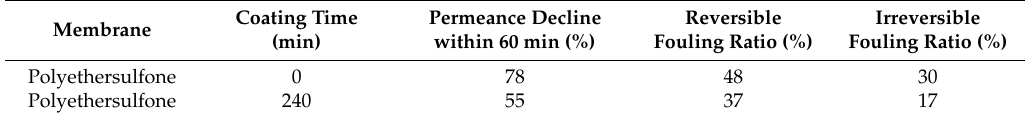
Figure 10. Fouling behaviour under cross-flow condition of a pure polyethersulfone membrane and a polydopamine membrane coated for 240 min, fouling solution: 61 mg/L BSA in water, transmembrane pressure one bar, velocity 0.97 m/s. Table 3. Fouling behaviour of pure and polydopamine-modified membranes as calculated flux recovery and fouling ratios.